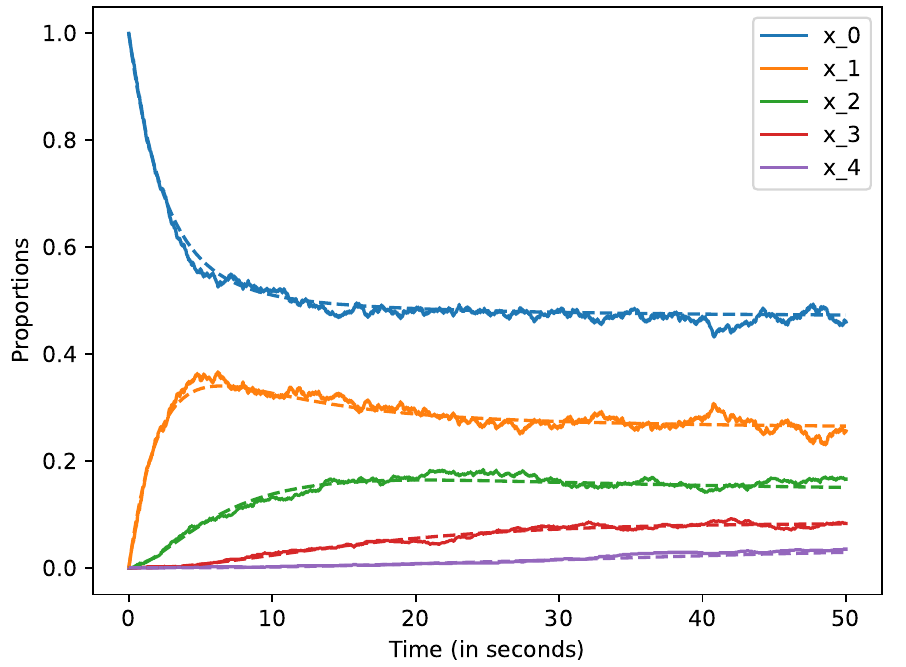
Figure 7. Mean-field approximation for N = 1000 devices. Time in